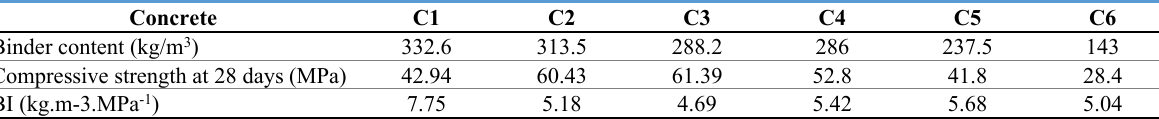
Table 7. Compressive strength and binder intensity of the concretes.